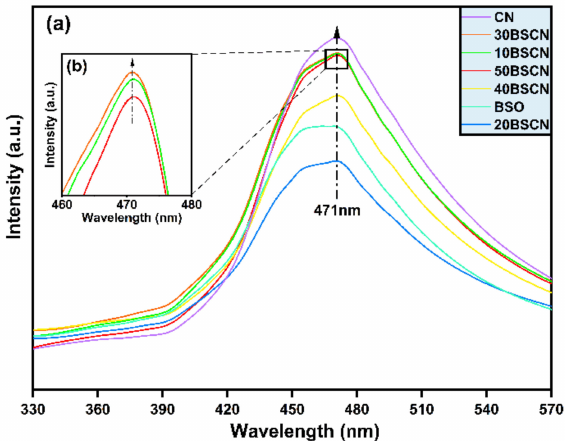
Figure 7. PL emission patterns of BSO, CN and BSCN ( a ) and the high-definition pattern ( b